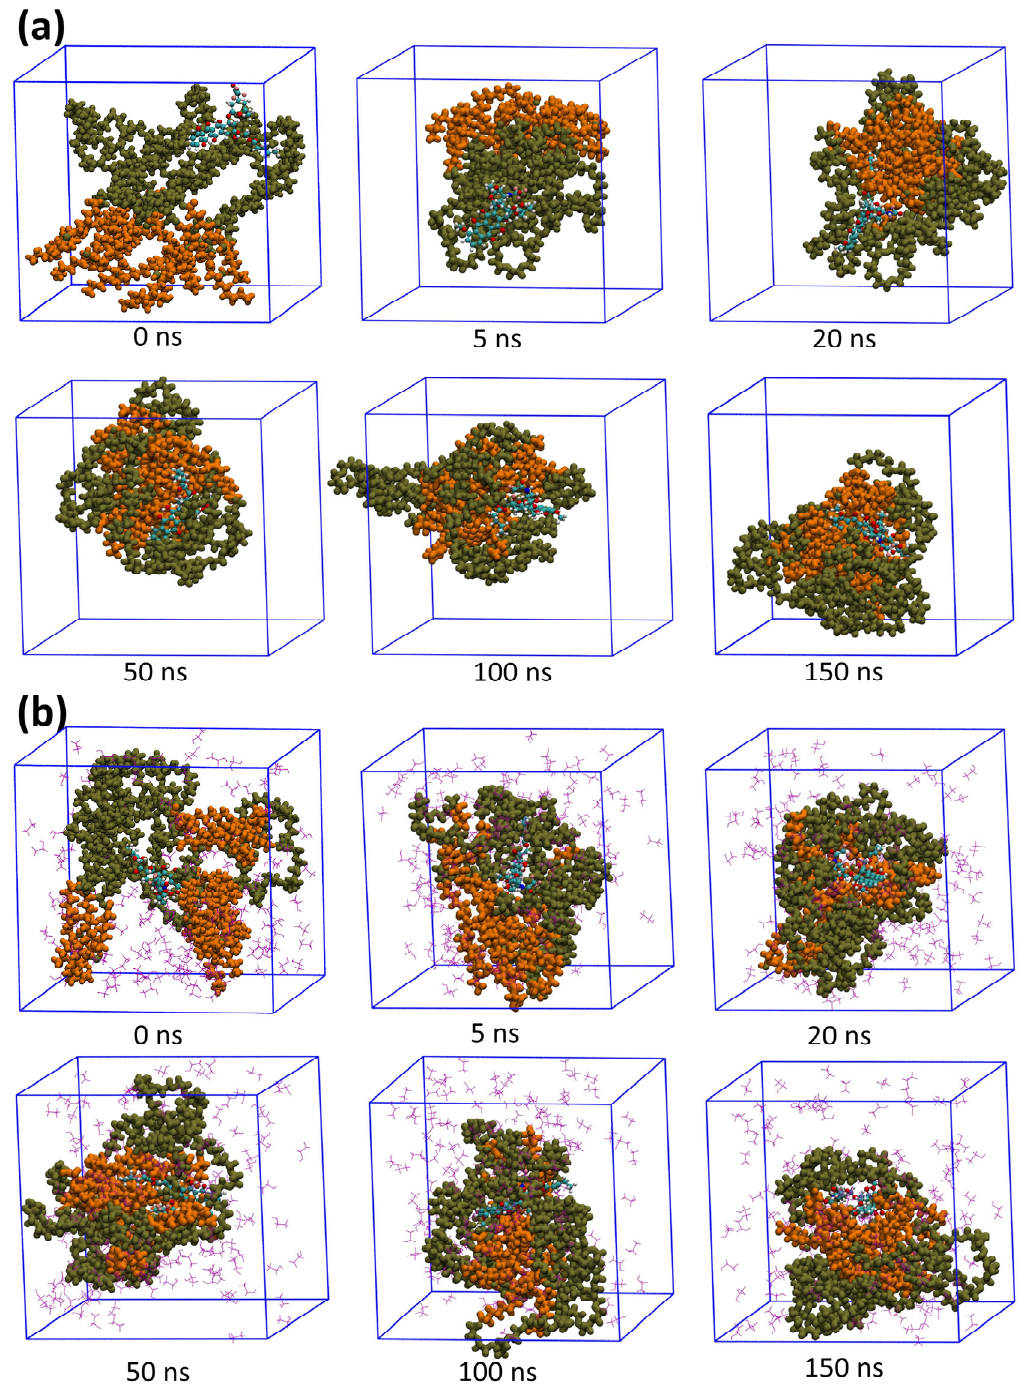
Figure 2. Trajectory snapshots at different simulation times of Valrubicin system ( a ) without cosolvents and ( b ) with cosolvents. The color scheme of atoms: purple lines represent cosolvent molecules; orange balls represent hydrophobic chains of polyoxyethylene 35 castor oil; brown balls represent hydrophilic chains of polyoxyethylene 35 castor oil; red, blue, cyan, and gray balls represent oxygen, carbon, nitrogen, and hydrogen atoms of drug molecules respectively. (Water particles have been removed for clarity).